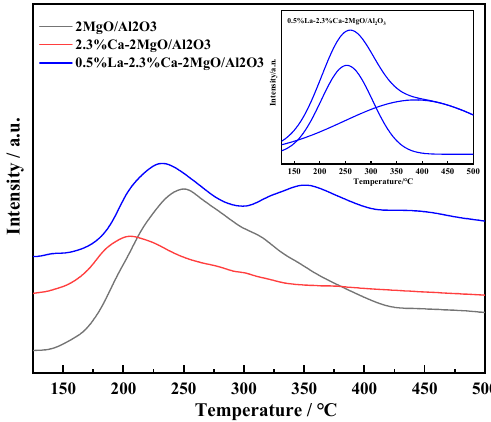
Figure 5. NH 3 ‐ TPD profiles of composite oxides. Table 3. Acid/Base properties of composite